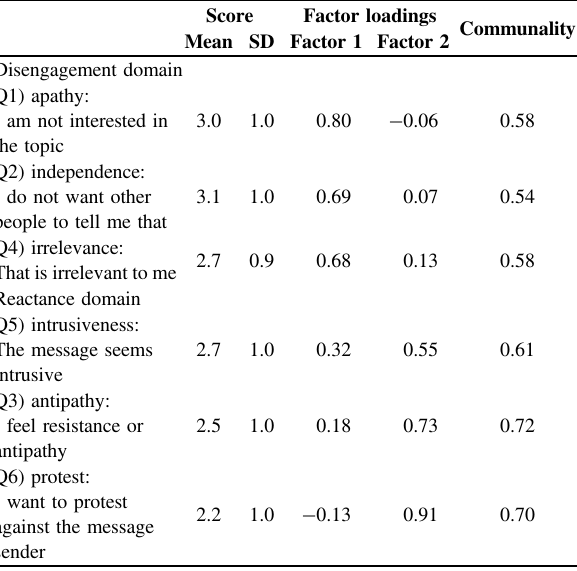
Table 2 Factor structure of the resistance